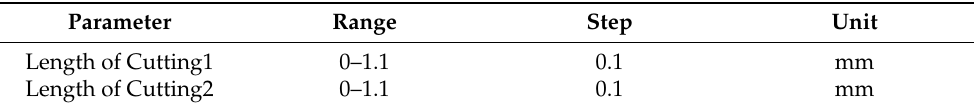
Figure 6. Variable of permanent magnet fixed bar. Table 2. Variable setting of permanent magnet fixed bar. Table 2. Variable setting of permanent magnet fixed bar.